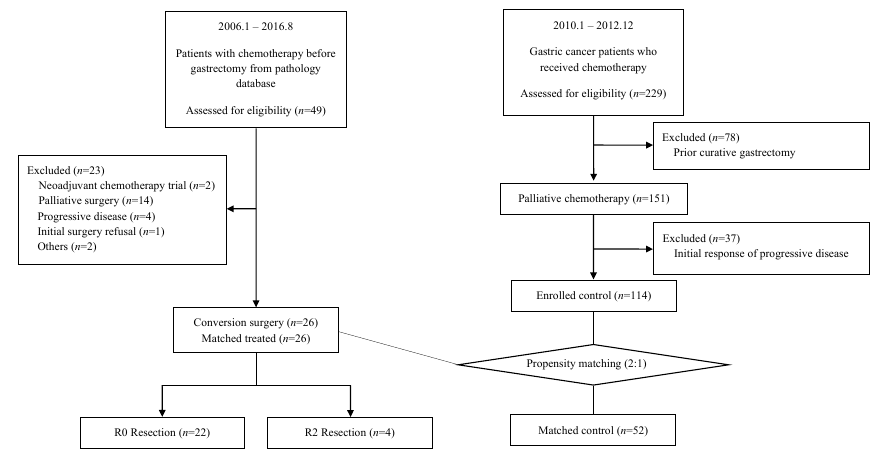
Figure 2. Consort diagram of the study.